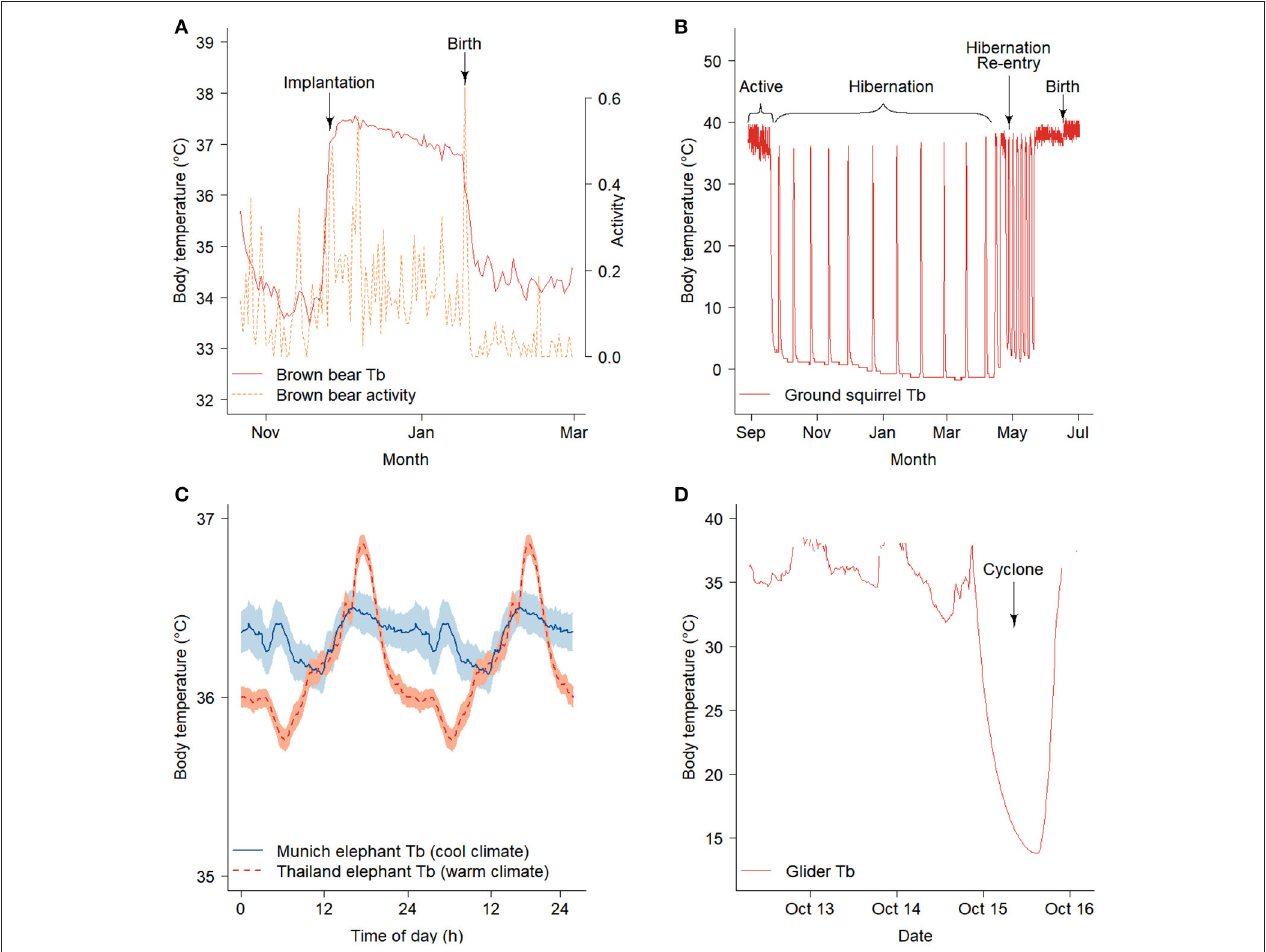
FIGURE 1 | Data collected using biologgers can potentially be used to describe climate-driven changes in the phenology and/or occurrence of reproduction. (A) Elevated body temperatures and activity indicate implantation and gestation in female brown bears with an additional a peak in activity characterizing parturition ( Friebe et al., 2014). (B) Female arctic ground squirrels re-enter hibernation and show unusually late and short bouts of torpor in response to late spring snow storms resulting in delayed parturition ( Williams et al., 2017). Biologgers also show the thermal response of animals to extreme events. (C) Asian elephants in a warm environment depressed body temperature during the cooler periods of the day to provide a thermal reserve for high temperatures later in the day (shading represents mean + / − s.e.m) ( Weissenbock et al., 2012). (D) A sugar glider enters torpor while experiencing heavy rains and high winds during a Category 1 cyclone (Nowack et al., 2015 ). Figures redrawn with